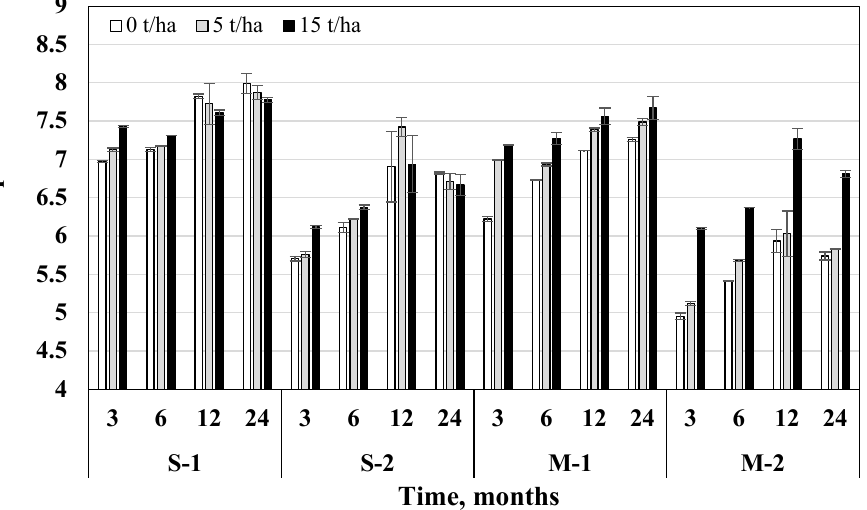
Figure Figure 6. Influence of biochar on soil pH changes in different tillage-fertilization systems (S— ploughless shallow tillage, M—direct drilling, 1—unfertilized, 2—fertilized) after 3, 6, 12, and 24 months from the beginning of the experiment, n = 2.